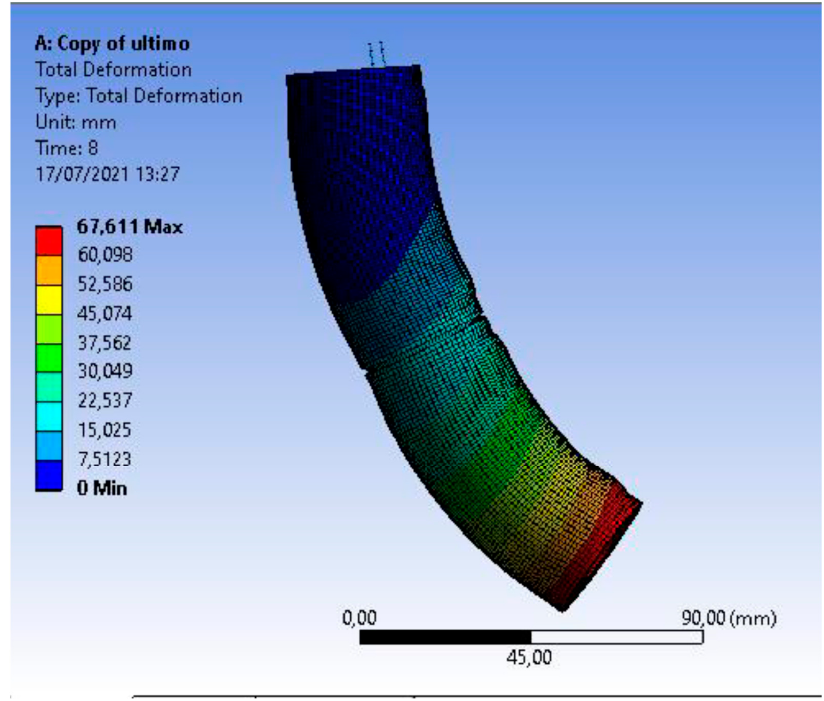
Figure 17. Deformation of the soft body of the robot under the action of the threads. Source: authors. Once the results were considered acceptable, the data was extracted. The extracted data de fi ne the curves and relate their de fl ection to the activation of the actuators. Conse- quently, three equidistant paths were de fi ned along the outside of each silicone segment, as seen in Figure 18.